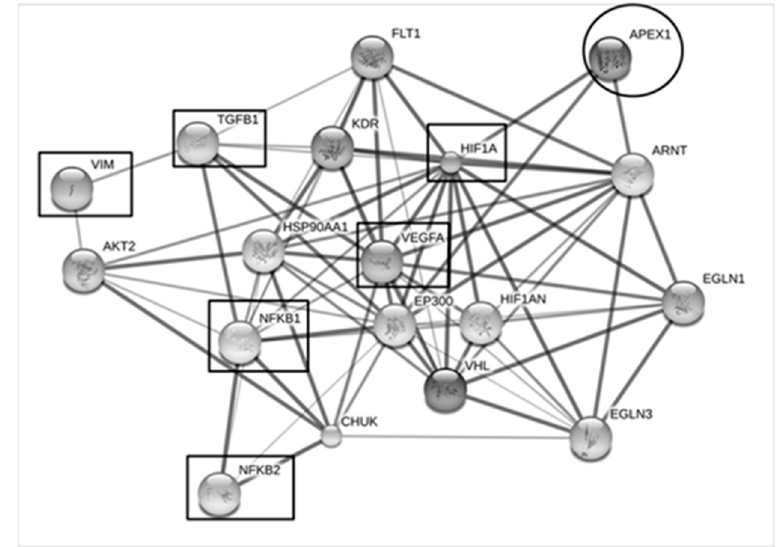
Figure 8. The interaction map of the APEX1 and metastatic processes-associated proteins. Protein-ligand interaction was predicted by STITCH Version 5.0. Protein-protein interactions are represented in solid lines. Stronger associations are represented by thicker lines. Weak associations are represented by thin lines. APEX1 was predicted to have strong interaction with vascular endothelial growth factor (VEGF), hypoxia-inducible factor-1alpha (HIF-1 α ), nuclear factor kappa B (NF- κ B), transforming growth factor β (TGF β ), and vimentin (VIM).